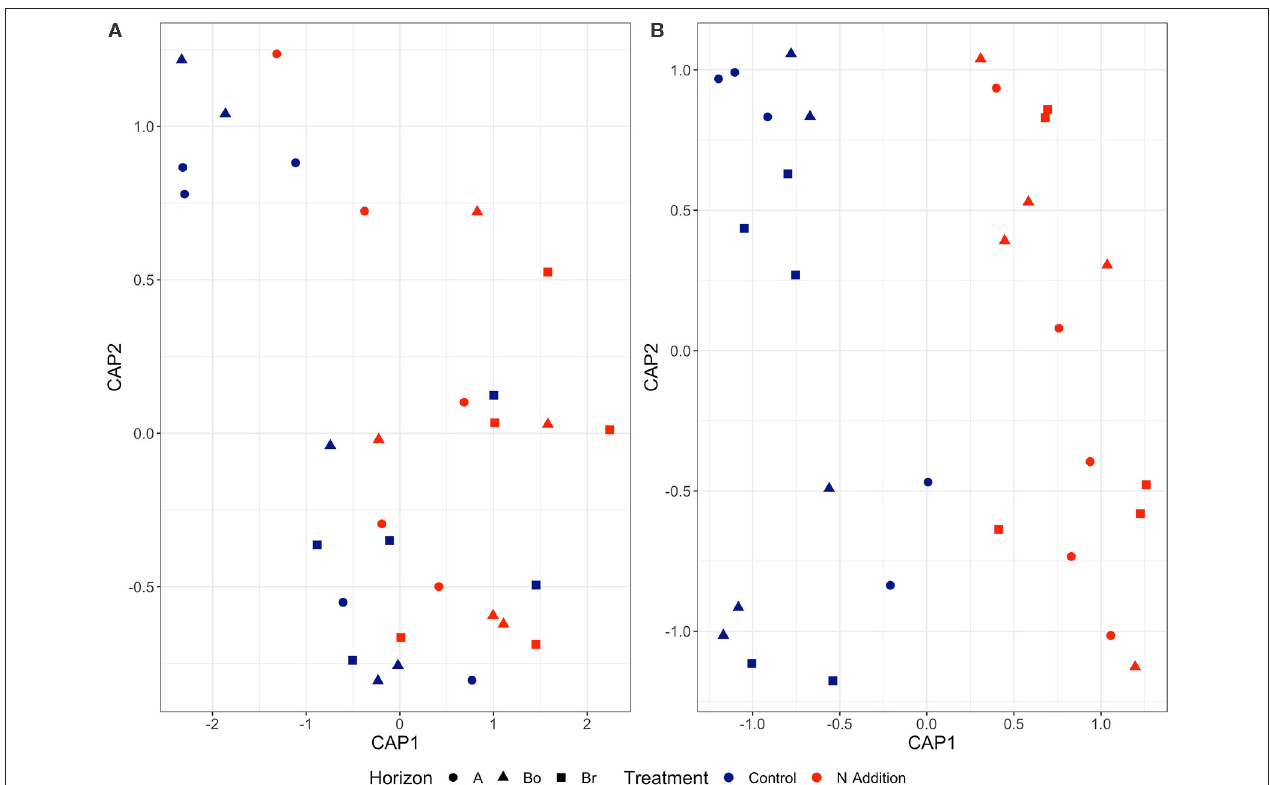
FIGURE 5 | Canonical analysis of principal coordinates (CAP) based on the Bray-Curtis dissimilarities for bacterial (A) and fungal (B) communities in the horizons of the mineral soil in the control and N-addition plots ( n = 5; A, A horizon; Bo, oxic B horizon; Br, reduced B horizon). The variation in microbial community structures was explained by each CAP axis (for bacteria: CAP 1, 5.2%; CAP 2, 3.9%; for fungi: CAP 1, 15.5%; CAP 2,